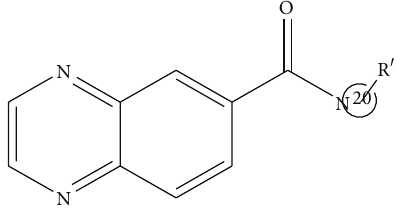
Figure 38: Chemical structure of compound 90 .